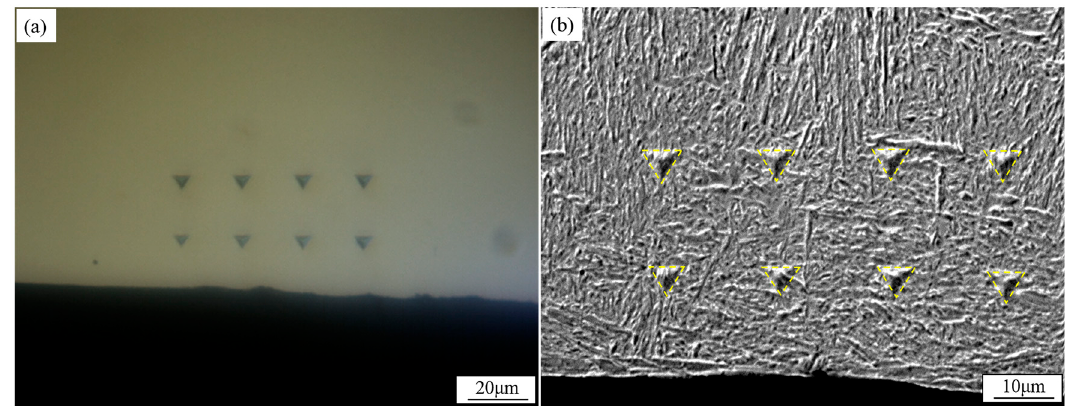
Figure 1. Dot array of indentations: ( a ) in a polished plane, the nanoindentations were detected; ( b ) in an etched plane, the nanoindentations crossed the grain boundaries in a microstructure.